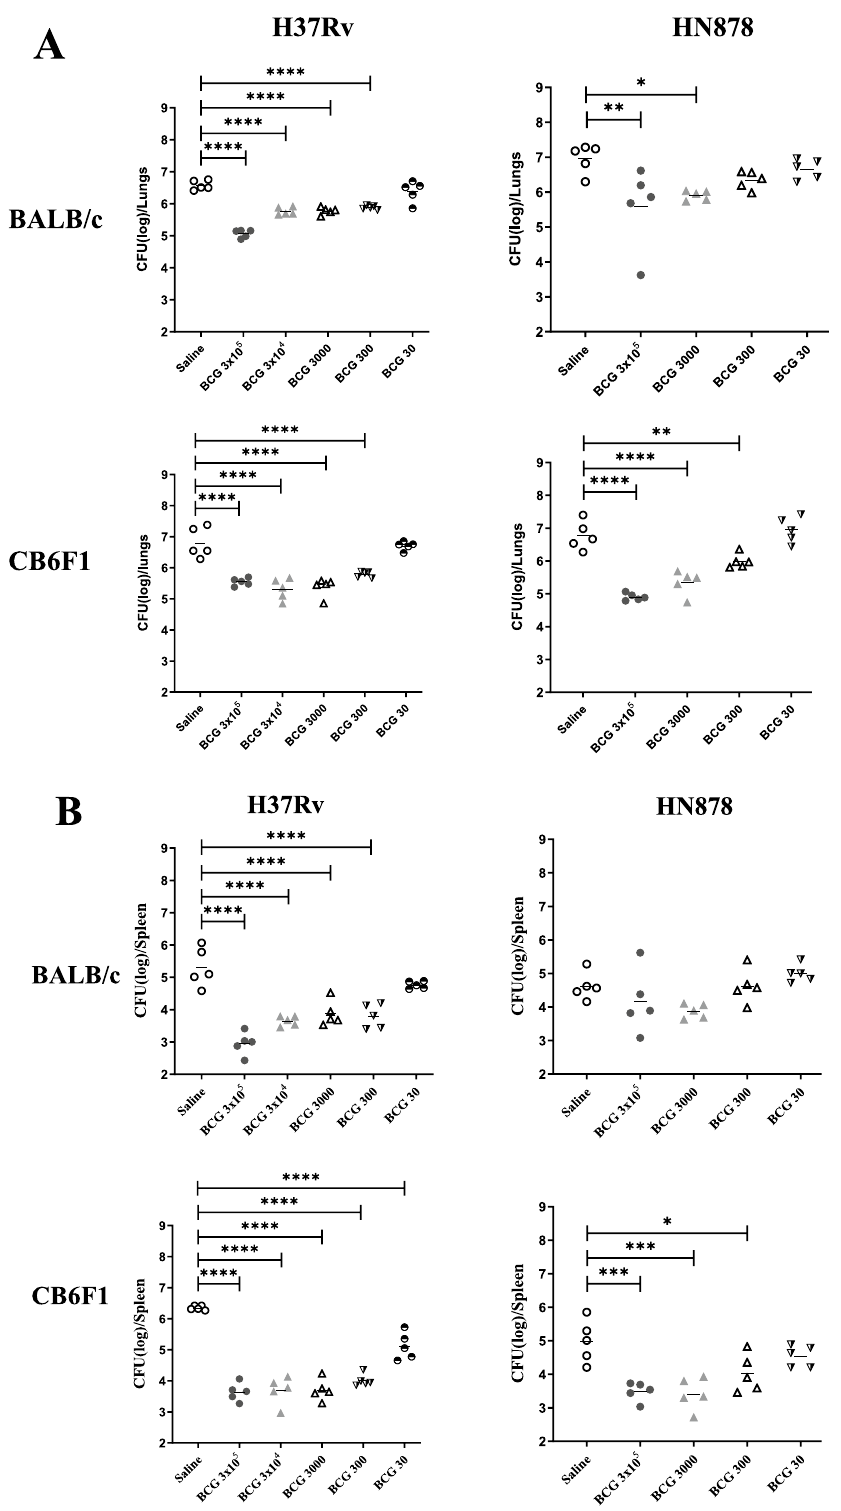
Figure 1. The CFU data for mice (five mice/group)—BALB/c and CB6F1, vaccinated with different BCG doses and challenged with HN878 and H37Rv. Four weeks post infection, the lungs and spleen were harvested, homogenates were plated on 7H11 agar plates and bacterial loads were determined as CFU/ml. Data is representative of two independent experiments for H37Rv challenge and one experiment for HN878 challenge. ( A ) Lungs CFU data as Log 10 protection for the vaccinated BALB/c and CB6F1 mice infected with H37Rv or HN878. ( B ) Spleen CFU data as Log 10 protection for the vaccinated BALB/c and CB6F1 mice infected with H37Rv or HN878. One-way ANOVA, Tukey’s multiple comparison test was performed for BALB/c and CB6F1 mice infected with H37Rv and HN878 strains. *ρ < 0.05, **ρ < 0.005, ***ρ < 0.0005, ****ρ <